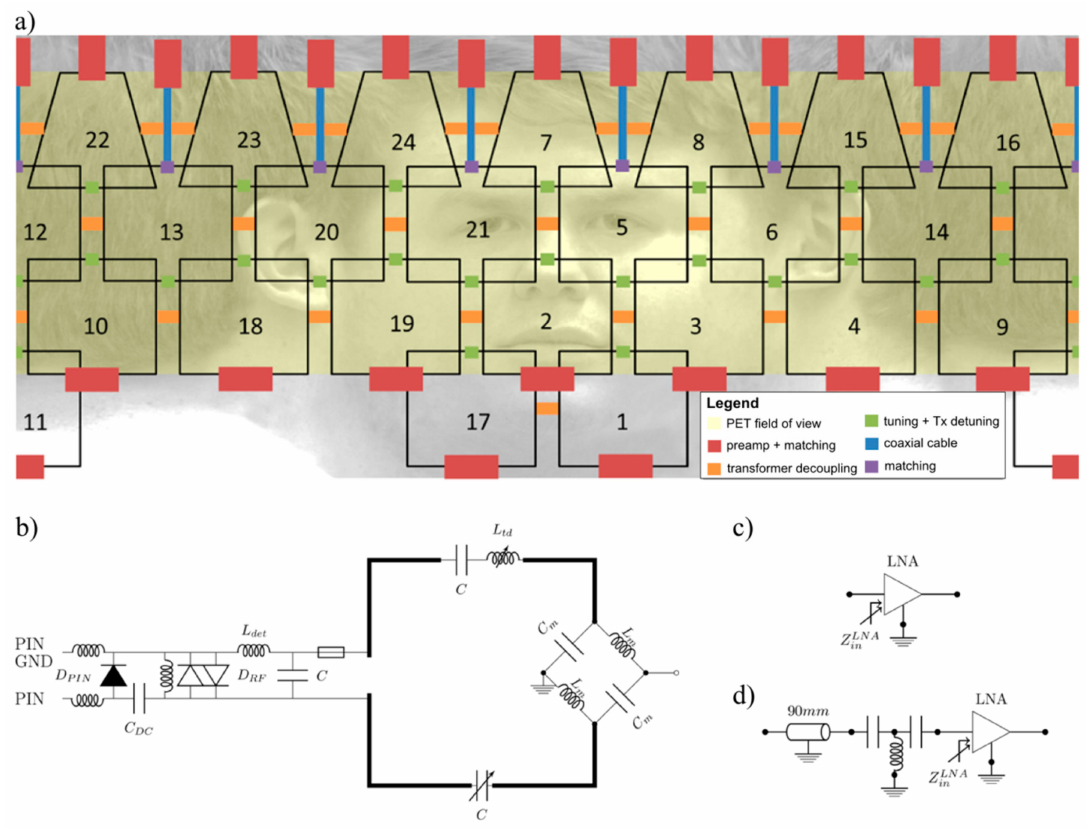
Figure 2. RF coil layout. ( a ) Unrolled layout of the 24-channel RF coil array; a description of the building blocks is given in the legend. Note the placement of heavily attenuating RF preamplifiers outside the PET field-of-view (FOV) (yellow area). ( b ) Circuit diagram of a single element. Two types of interfaces were used: ( c ) with direct connection to the preamplifier, and ( d ) with a coaxial cable, a phase shifter, and then the